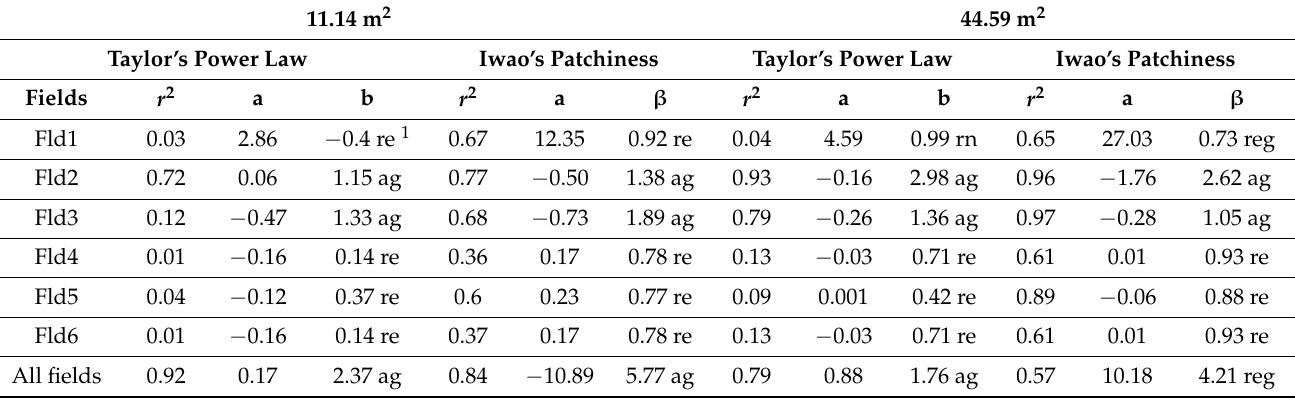
(Table 6). The index of dispersion, mean crowding, Green’s index, and Lloyd’s mean combined (Figure 1). Table 6. Distribution pattern of thrips larvae in six fields based on flower